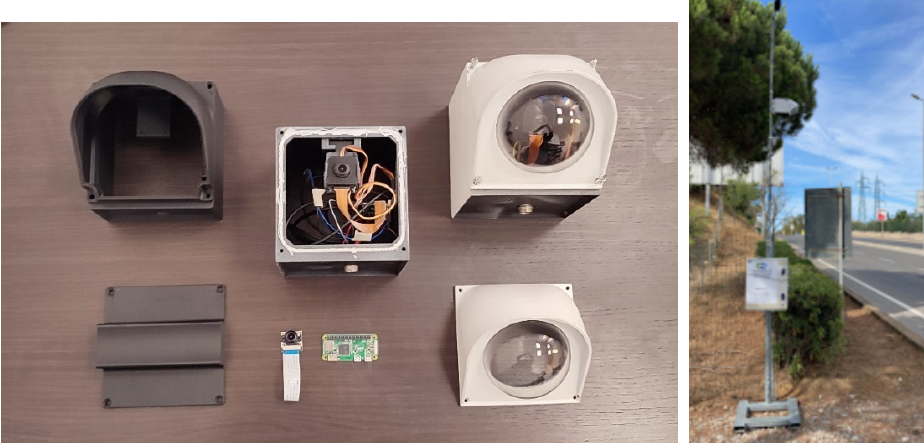
Figure 2. Video camera system using a single-board computer, an infrared wide-angle camera, and a 3D-printed casing and its application with sound level meter and video camera system at roadside in